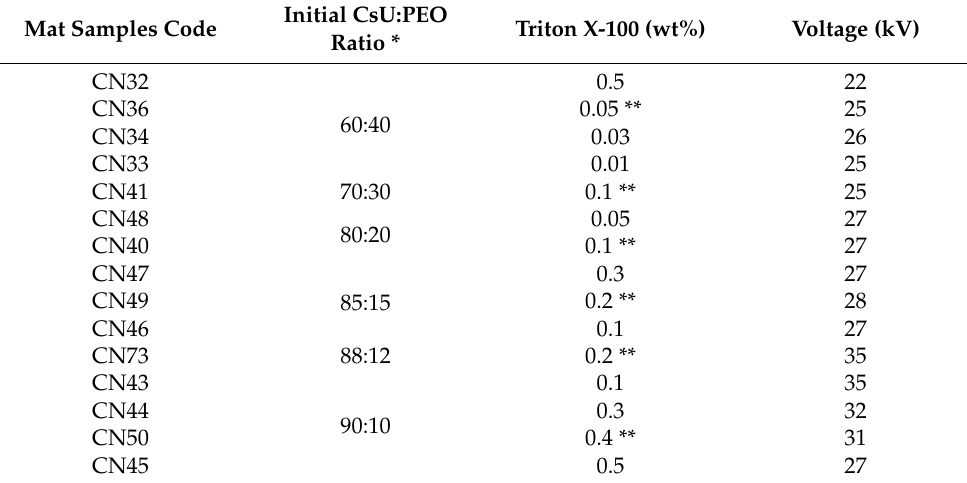
needle = 15 cm, Temperature of ESP = 25 ◦ C. Table 3. Electrospinning conditions for